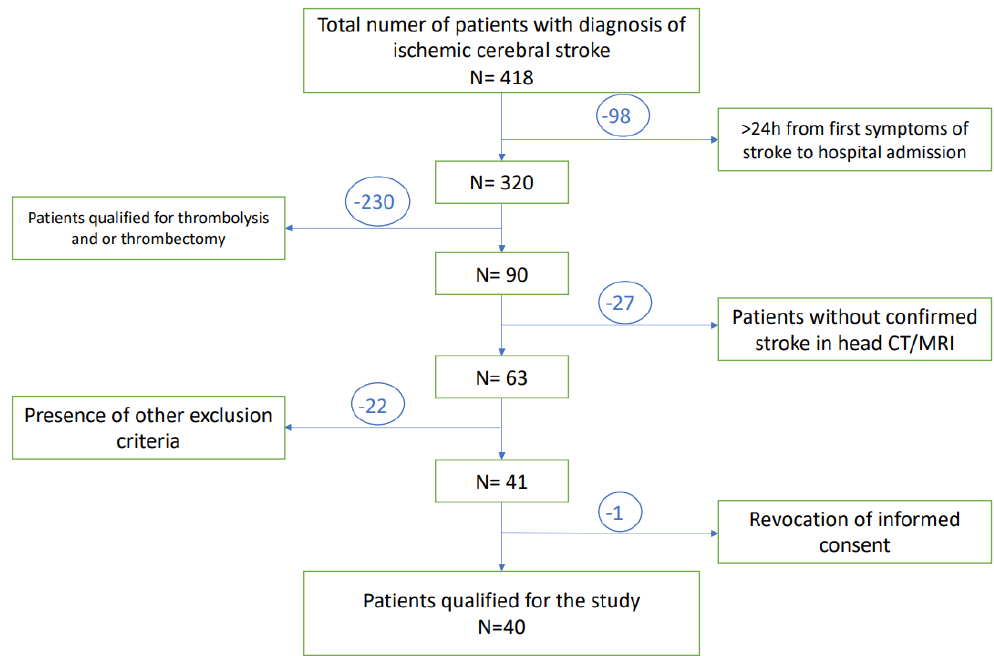
Figure 2. A flow chart of the patients selection.